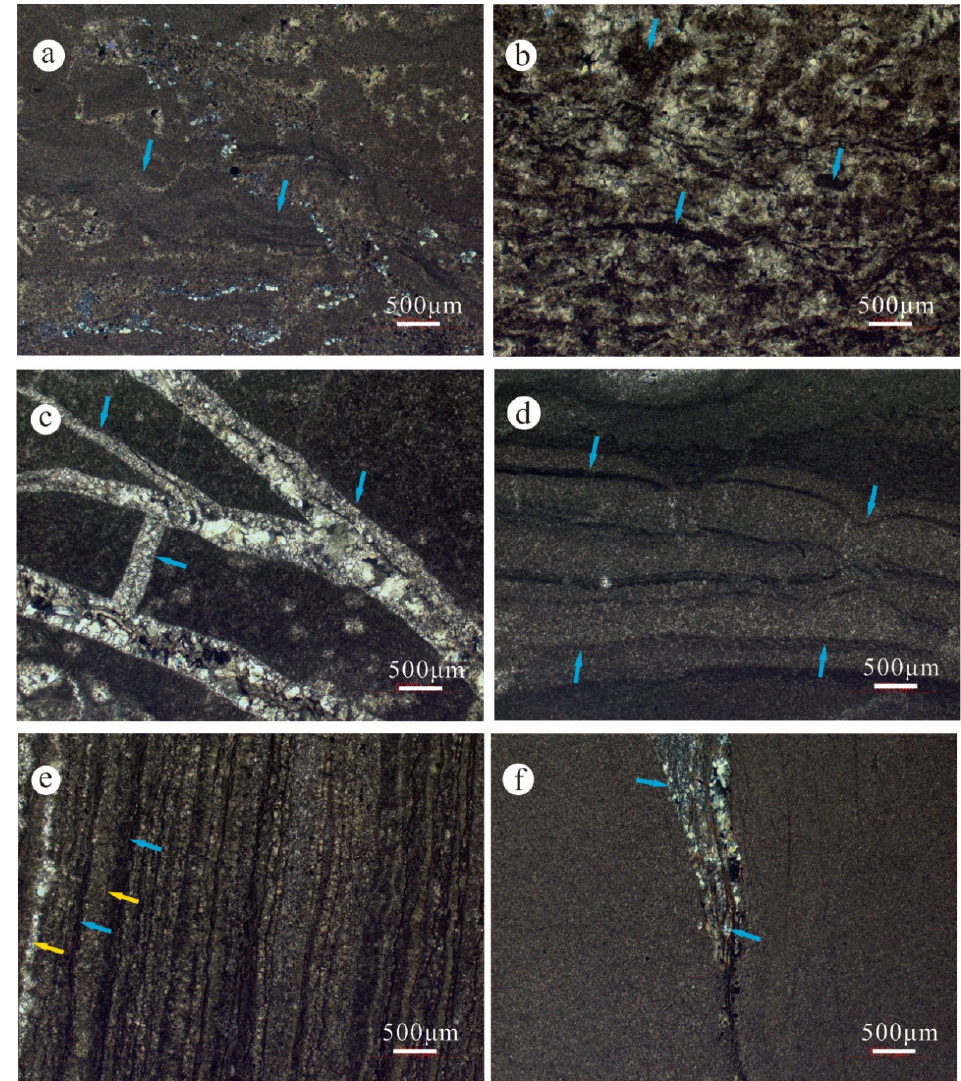
Figure 4. Photomicrographs of the carbonate rocks from the Gaoyuzhuang ( a – c ) and Wumishan Formations ( d – f ). ( a ) Well ‐ developed micro ‐ sedimentary beddings (blue arrows) in the lamellar stromatolite dolostone in the upper Gaoyuzhuang Formation. ( b ) Micritic (blue arrows) and fine ‐ grained textures in the fine ‐ grained dolostone from the middle Gaoyuzhuang Formation. ( c ) Calcite within the lime dolostone from the lower Gaoyuzhuang Formation. Dolomites are mostly anhedral and micritic and cut by different calcite vein complexes (blue arrows). ( d ) Dolomites in the upper Wumishan Formation are densely packed with each other and show microscopic stratification (blue arrows). ( e ) Well ‐ developed cleavages in the middle Wumishan Formation showing typical cleavage domains (blue arrows) and microlithons (yellow arrows). ( f ) Uncemented dissolution and partially cemented fractures with calcite cement deposits (blue arrows) of the fine ‐ grained dolostone in the lower Wumishan Formation.